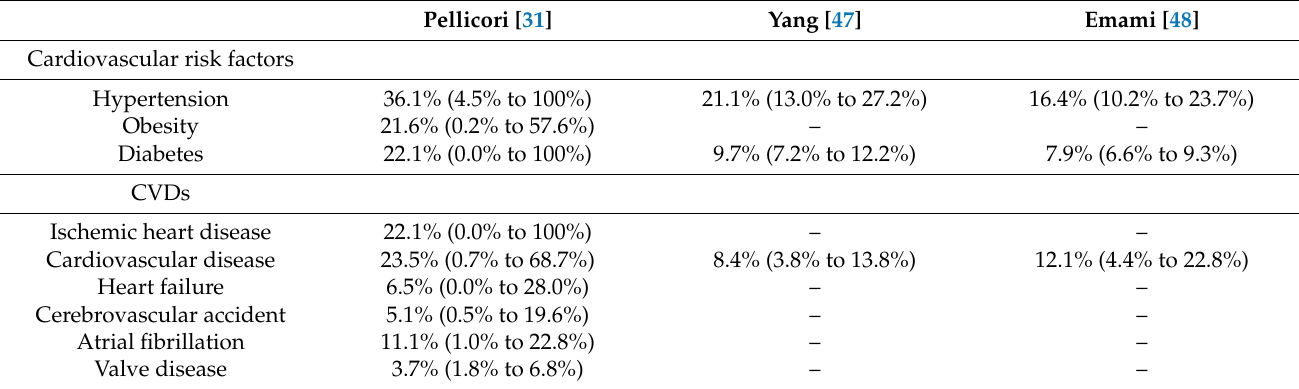
Table 1. Prevalence and range (%) of cardiovascular risk factors and CVDs in hospitalized patients with COVID-19. Pellicori [31] Yang [47] Emami